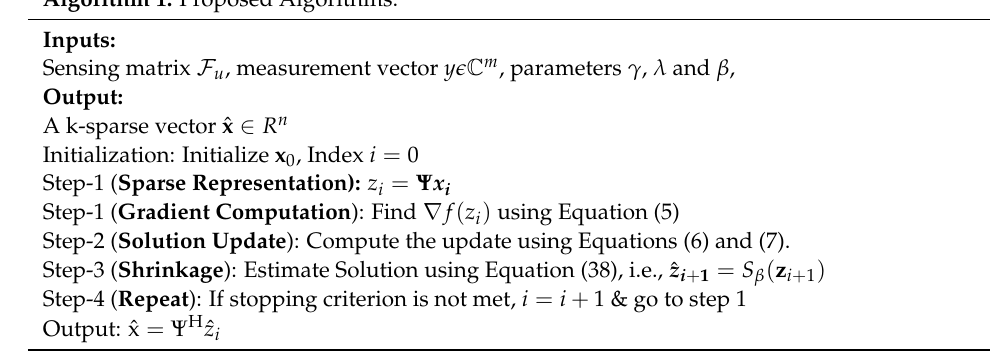
Algorithm 1. Proposed